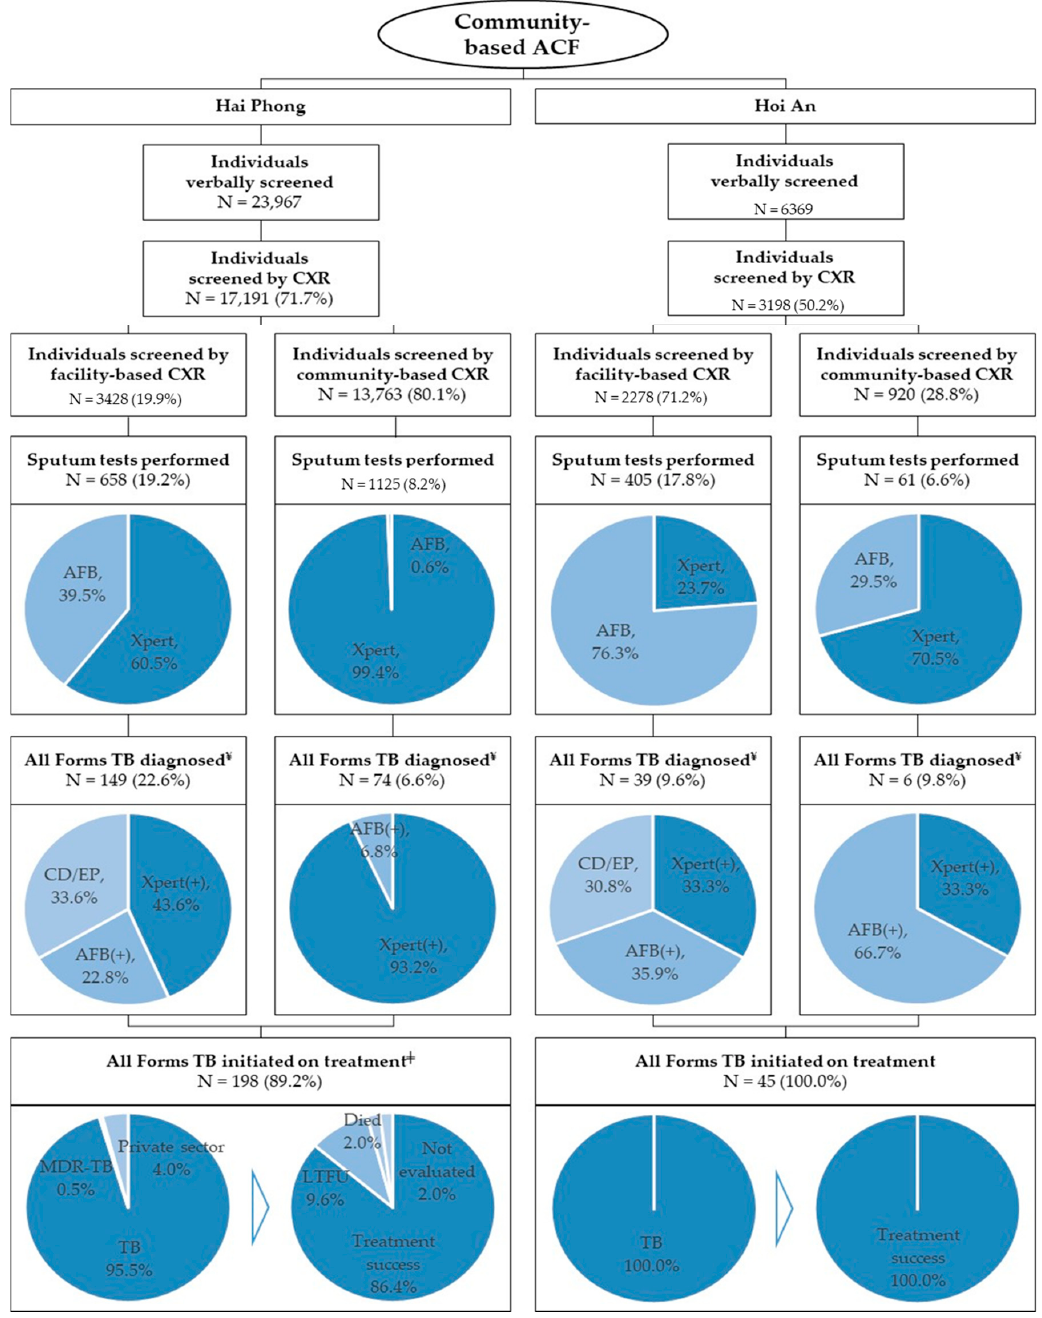
Figure 4. TB care cascade by city and CXR screening site. Hai Phong and Quang Nam, Viet Nam.